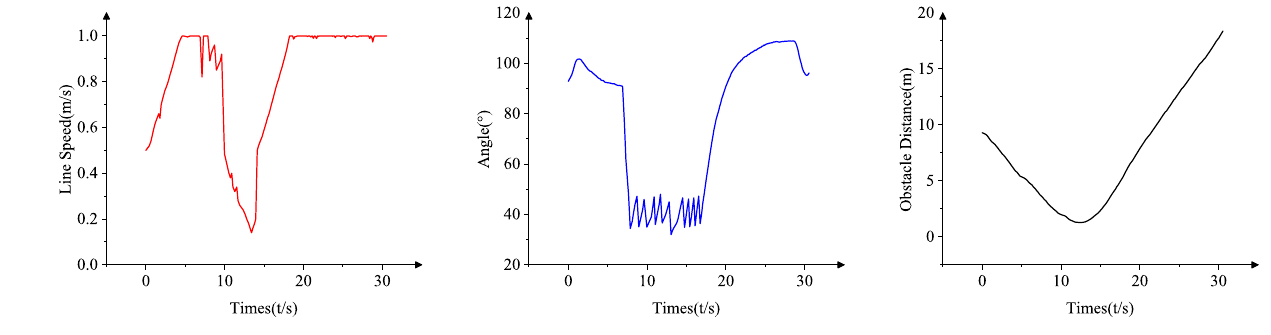
Figure 20. Crossing situation for the improvement of the PSO-based search method.